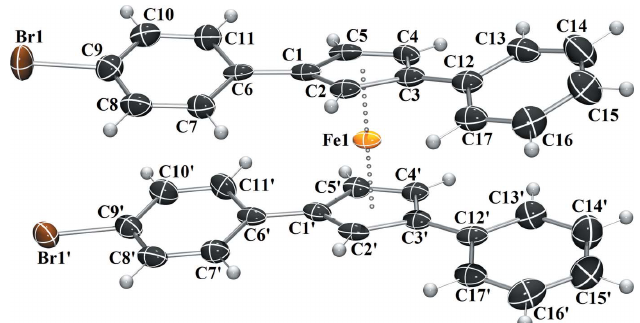
Figure 1 The molecular structure of the title compound. Displacement ellipsoids are shown at the 50% probability level. Only the primary disorder component for Br1 and associated H atoms is